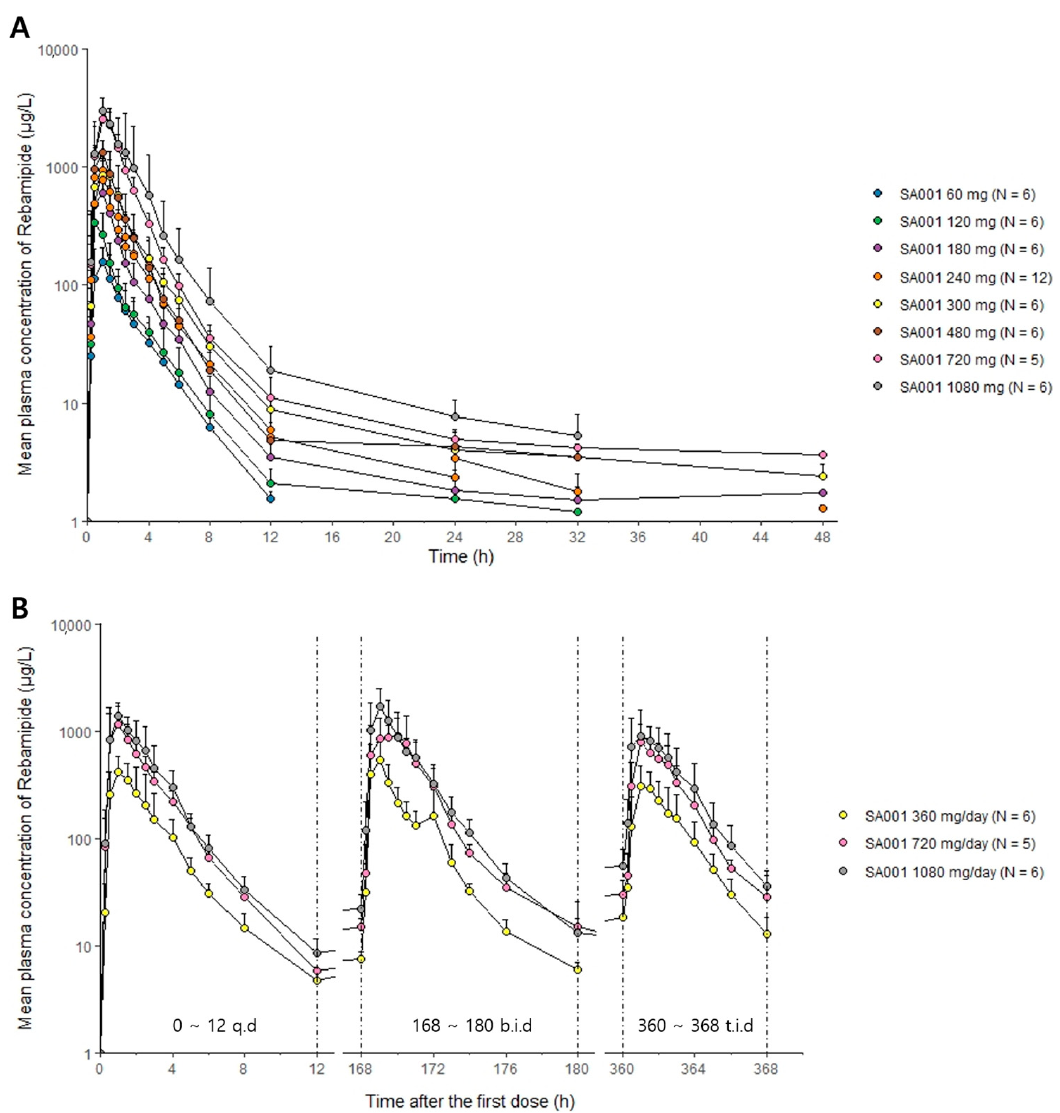
Figure 1. Mean plasma concentration-time profiles of rebamipide after ( A ) single and ( B ) multiple oral administration of SA001 in log-linear scale. SA001 was administered twice a day (b.i.d.) with half the assigned dose until 180 h after the first dose and three times a day (t.i.d.) with one-third of the assigned dose from 180 to 360 h after the first dose in the multiple ascending dose cohort. Bars represent standard deviations. Abbreviations: q.d.; quaque die (once a day).